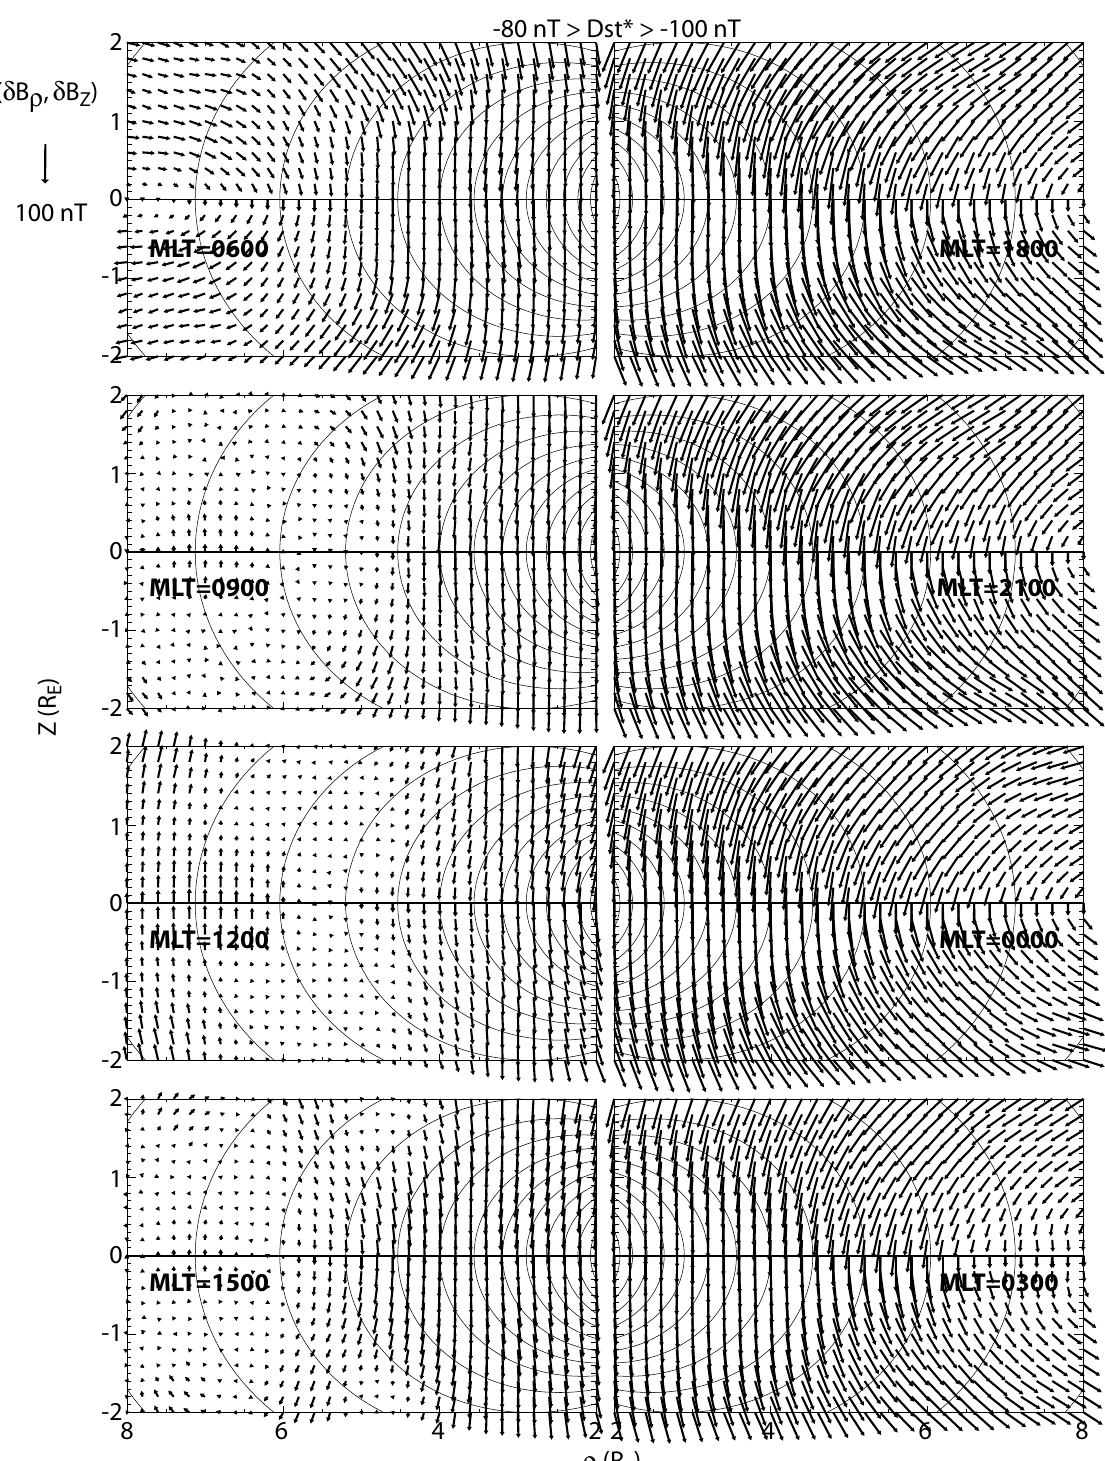
Fig. 4d. Meridional projection of the perturbation magnetic field arrows at equally spaced grids with superimposed dipole field lines in the meridian plane in each of the 8 magnetic local time bins and for each of the four D st * range: (d) − 80nT >D st * > −